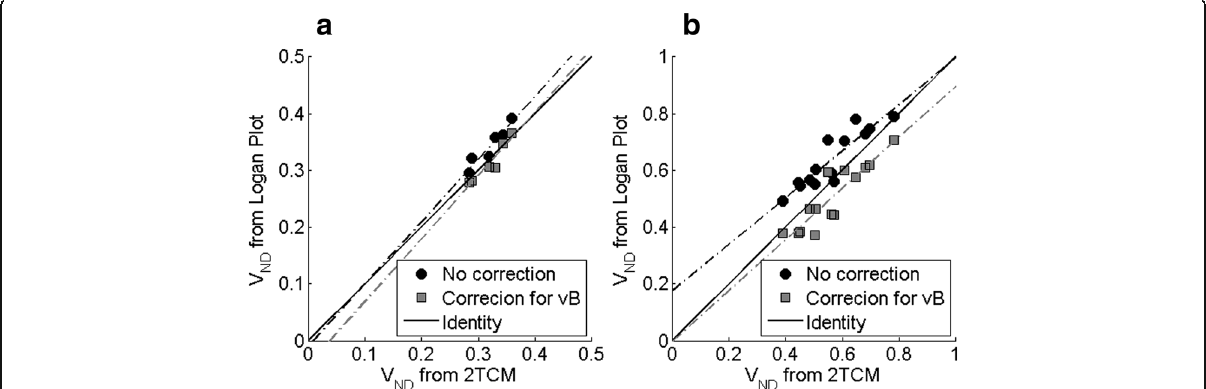
Fig. 4 Distribution volumes ( V T ) obtained with 2TCM plotted against those obtained with Logan plot for cerebellum with and without the correction described in Eq. 8, for a [ 11 C]raclopride and b [ 18 F]MNI-659